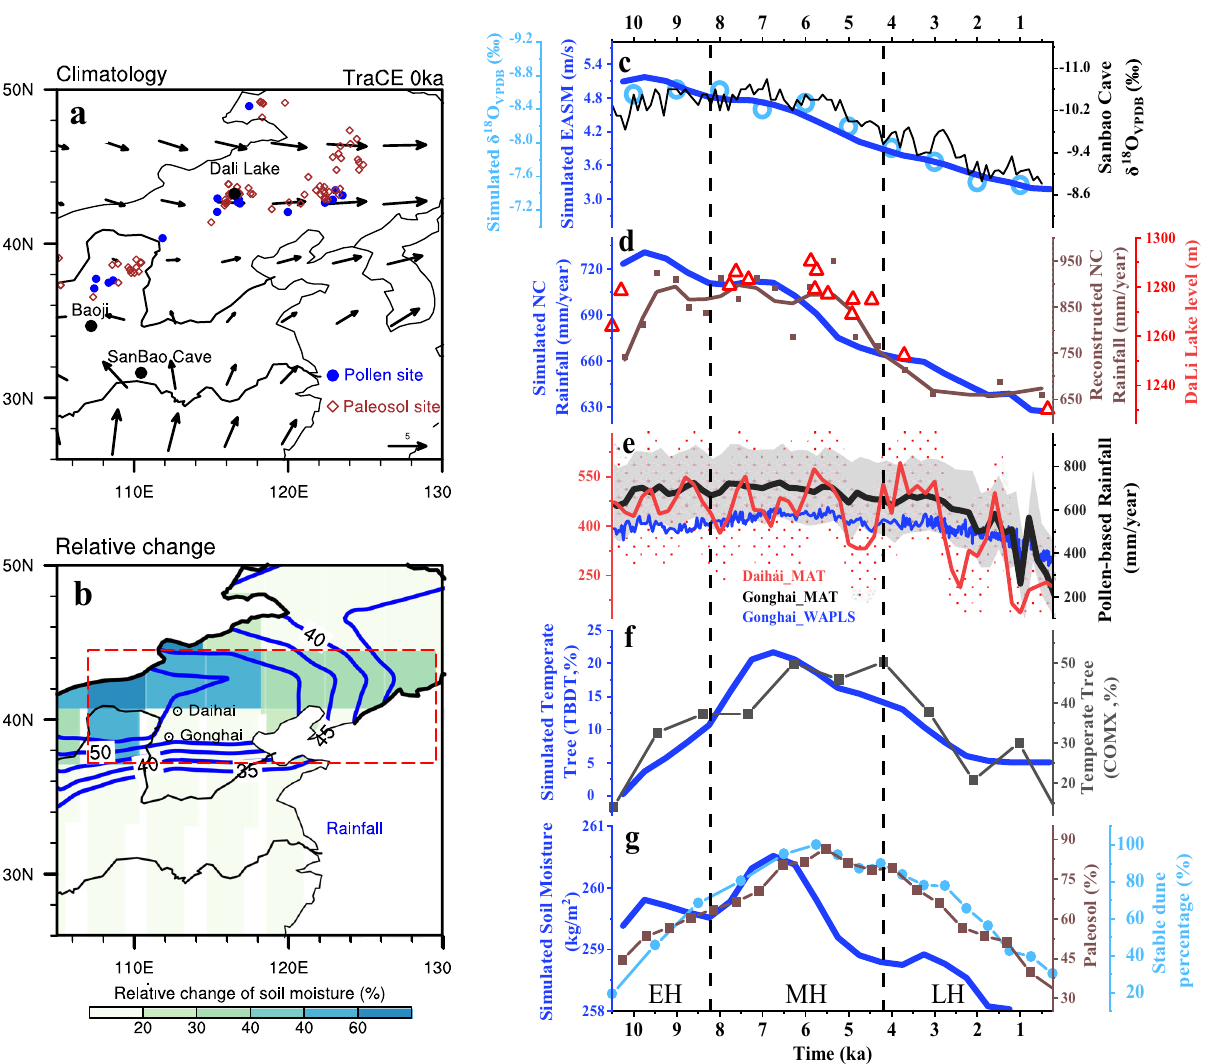
Fig. 1 Holocene East Asian Summer Monsoon (EASM), Northern China (NC) rainfall and ecosystem in proxy records and TraCE21 simulation. a Present-day EASM wind in TraCE21 simulation (vector, June to August mean at 850-hPa level). b Relative changes (in %) of annual rainfall (blue contours) and upper layer (0.5-m) soil moisture (shading) over Holocene in TraCE21 simulation. c EASM evolution as indicated by the 850-hPa meridional wind averaged over the East Asia in TraCE21 simulation (blue), isotope δ 18 O of Sanbao Cave 10 in the proxy record (black curve) and isotope simulations 23 (cadetblue circles). d Annual rainfall (blue curve) averaged over the NC region (marked in red-dash box in b ) in TraCE21 simulation and reconstructed from 10 Be of Baoji on the Chinese Loess Plateau 11 (brown dots and line); lake level of Dali 12 is also plotted in red triangles. e Pollen-based reconstruction of annual rainfall in Daihai lake using Modern Analogue Technique (MAT) method (red) and in Gonghai using the methods of MAT (black) and weighted- averaging partial least squares (WAPLS, blue 13 ). The 1 σ spread (68% con fi dence interval) of MAT reconstruction is also plotted in dots and shading for Daihai and Gonghai lakes, respectively. f Percentage of temperate broad-leave deciduous tree (TBDT) in TraCE21 simulation (blue) and reconstruction from fossil-pollen record of cool mixed tree (COMX 14 , black) over NC. g Upper layer soil moisture in TraCE21 simulation (blue) and its reconstruction from regional paleosol 14 (brown dots and line) and stable dune percentage over NC 15 (cadetblue dots and line). The sites of records used in c – g have been located in a and b . Temporal spans of the early Holocene (EM), mid-Holocene (MH) and late Holocene (LH) are illustrated with vertical dashed lines in c – g